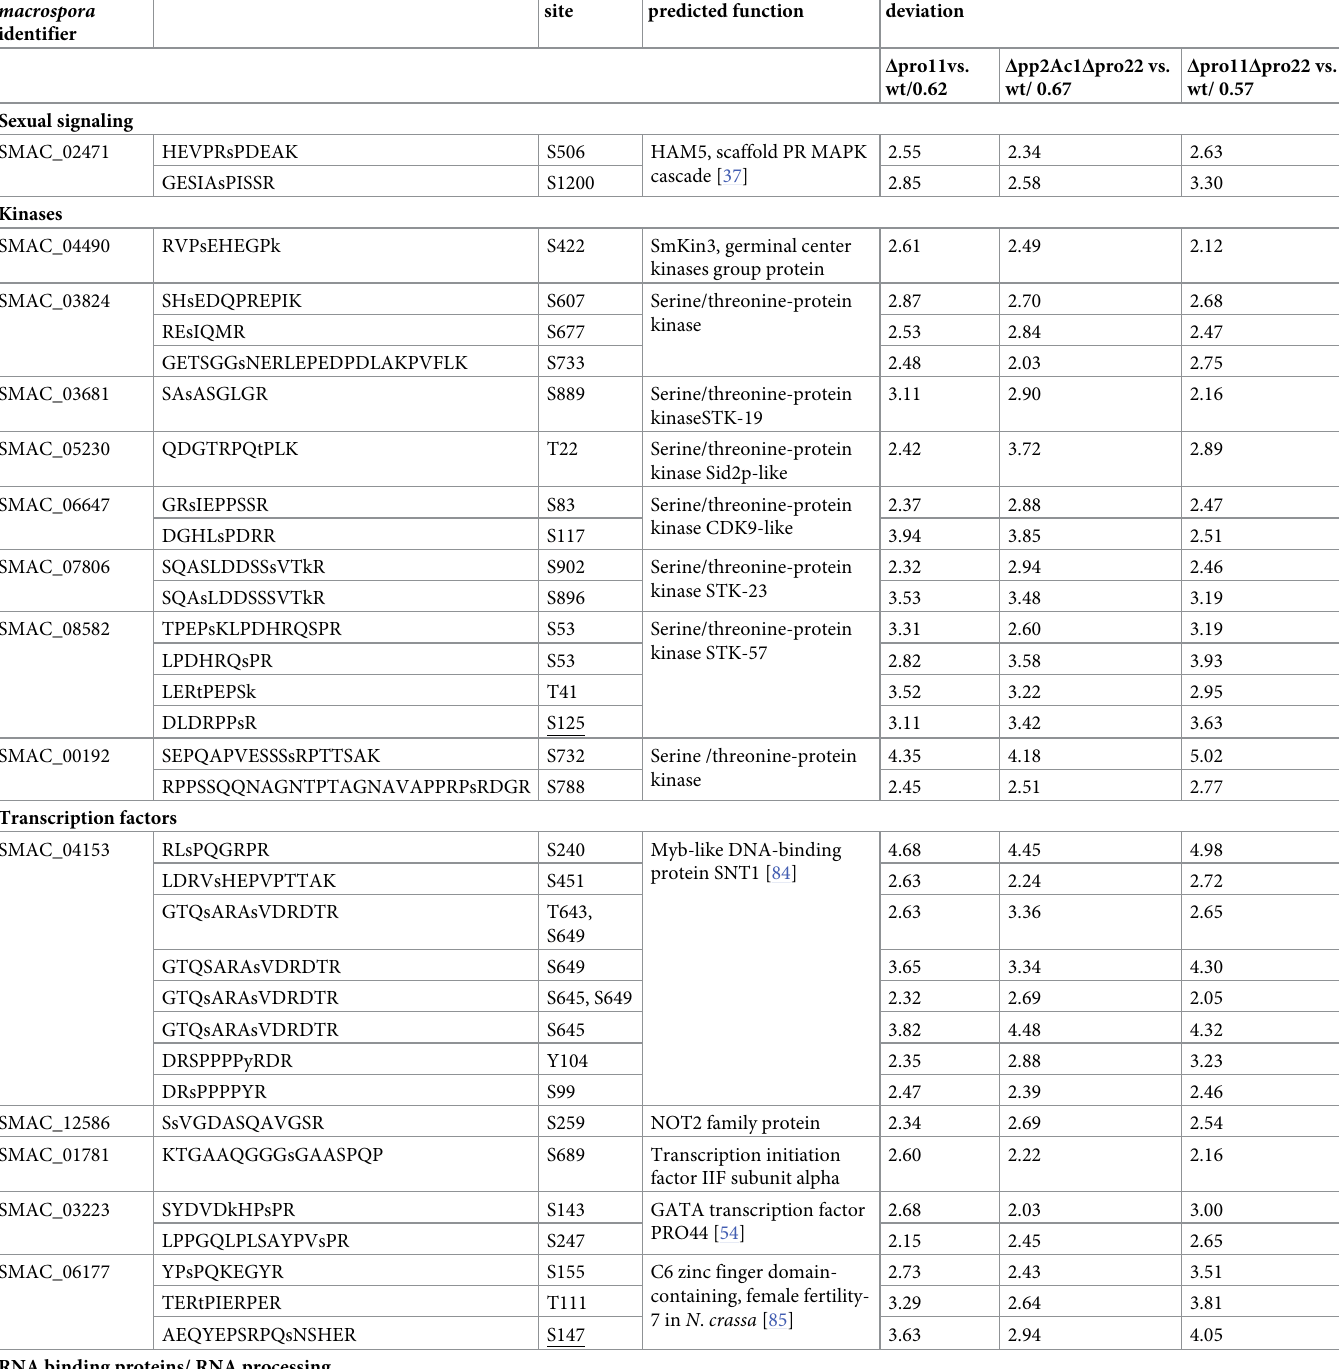
Table 1. Regulated phosphoproteins in the three investigated STRIPAK mutants Δ pro11, Δ pp2Ac1 Δ pro22 and Δ pro11 Δ pro22. Given are 61 differentially phosphor- ylated peptides from 22 selected proteins. For each phosphorylation site, log2 ratio of reporter ion intensity in deletion strain and wild type relative to the respective stan- dard deviation are given. Underlined are those phosphosites, which were previously detected to be differentially phosphorylated [21]. Lower case letters indicate phosphorylated amino acid residues. Sordaria